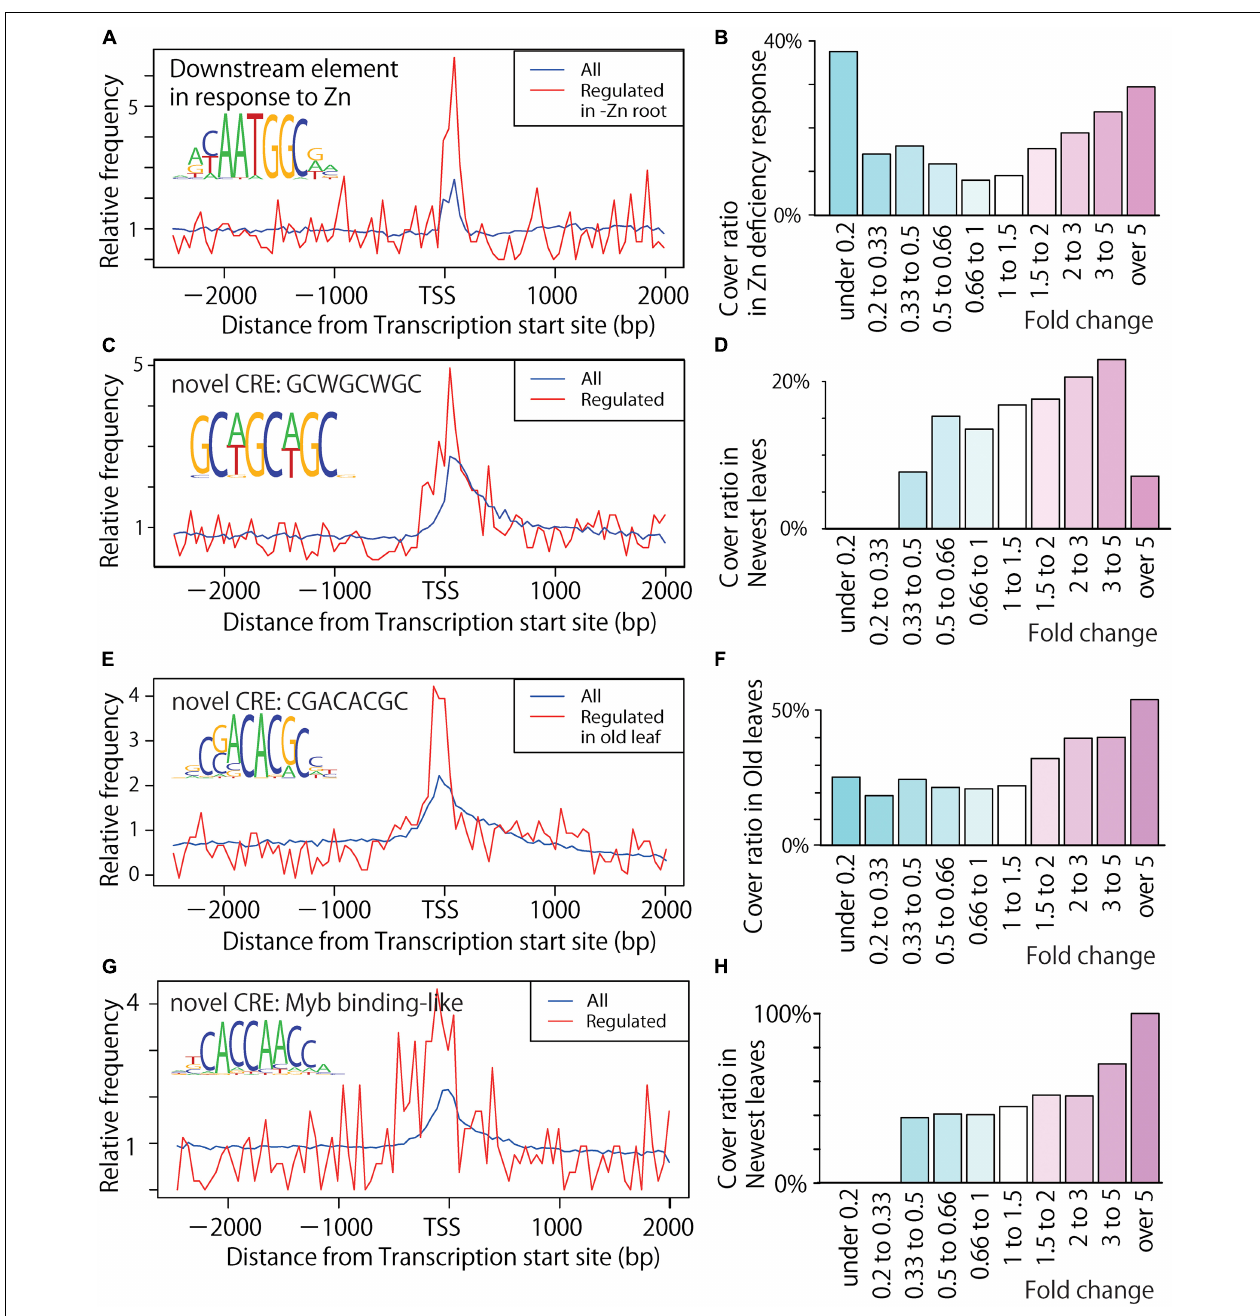
FIGURE 5 | Distribution of novel CRE candidates upstream of Fe excess-responsive genes. (A) Distribution of the ACAATGGC motif (novel) in all genes and Zn deficiency-regulated genes in root tissue. Blue line shows all genes and red line shows the Fe excess-regulated genes. (B) Coverage ratio (percentage of genes including motif among the up- or down-regulated genes by Zn deficiency as fold changes described under graph) of the ACAATGGC motif (novel) in the –500 bp to +150 bp area relative to the transcription start site (TSS) of Zn deficiency-treated root tissue. (C) Distribution of the GCWGCWGC motif (novel) in Fe excess-treated newest leaves. (D) Coverage ratio of the GCWGCWGC motif (novel) in newest leaves. (E) Distribution of the CGACACGC motif (novel) in Fe excess-treated old leaf tissue. (F) Coverage ratio of the CGACACGC motif (novel) in Fe excess-treated old leaf tissue. (G) Distribution of the Myb binding-like novel motif (CACCAACC) in Fe excess-treated newest leaves. (H) Coverage ratio of the Myb binding -like novel motif (CACCAACC) in Fe excess-treated newest leaf tissue. Graphs (A,C,E,G) show relative frequency compared to the average frequency in each 50 bp window within –3,000 to +2,000 bp of the TSS. Graphs (B,D,F,H) show coverage ratio of the motifs in the -500 bp to +150 bp area relative to the TSS in Fe excess-treated tissues. Numbers below the graphs (B,D,F,H) indicate gene expression ratios in Fe excess- or Zn deficiency-treated rice compared to non-treated rice.